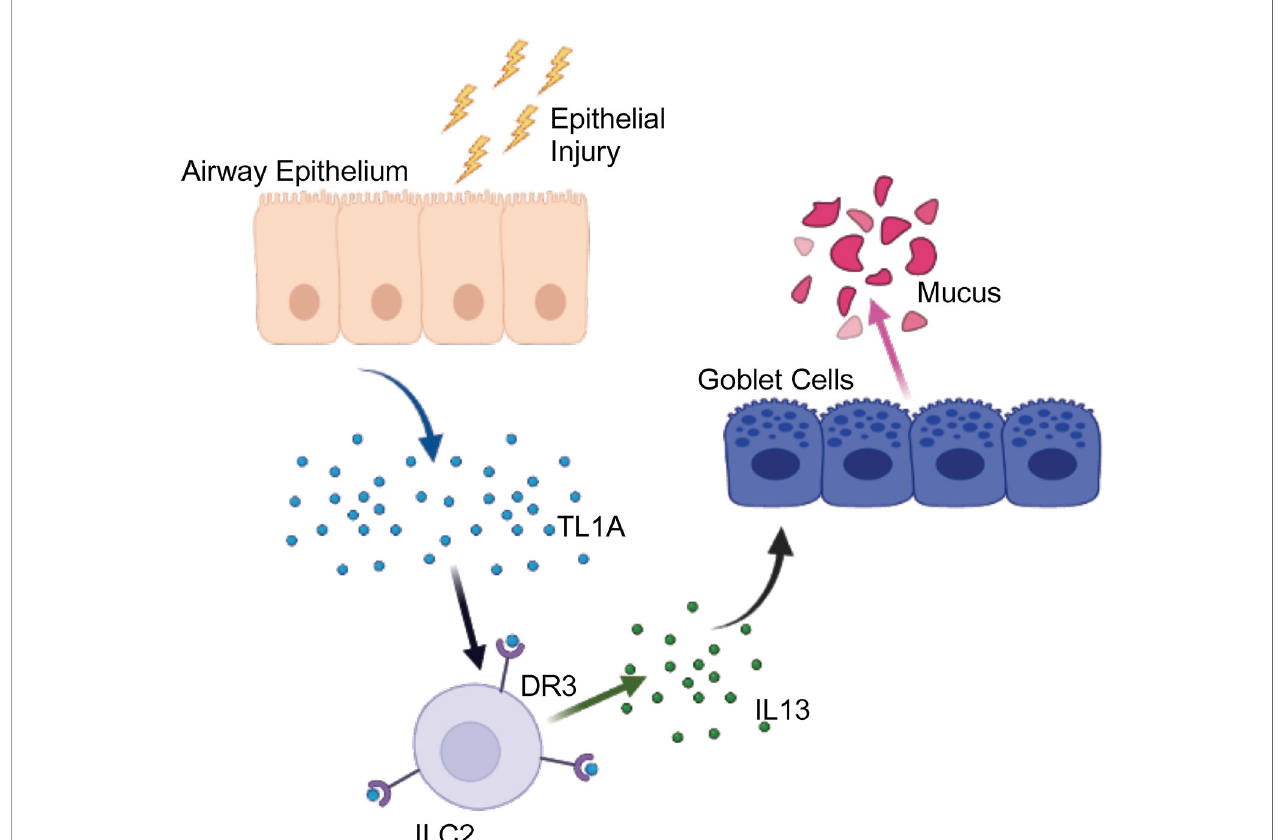
FIGURE 5 | Graphical Abstract. Upon epithelial injury, such as exposure to allergens, TL1A is produced and acts on ILC2 via DR3 to promote IL13 secretion, leading to mucus production. Created with